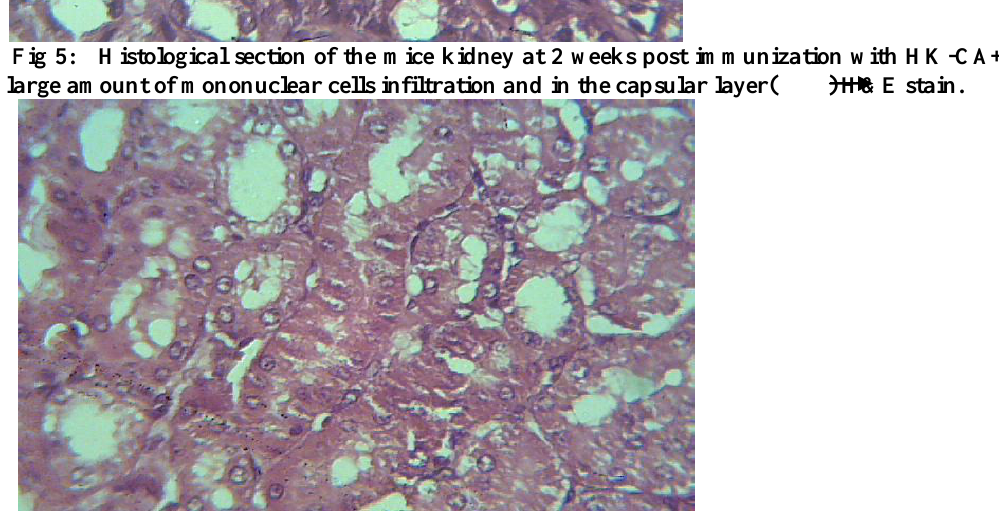
Fig 6 : Histological section of the mice kidney at 2 weeks post immunization with HK-CA showed no clear pathological lesions were reported in the kidney.H&E